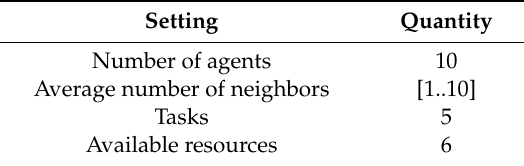
Table 2. The details of the